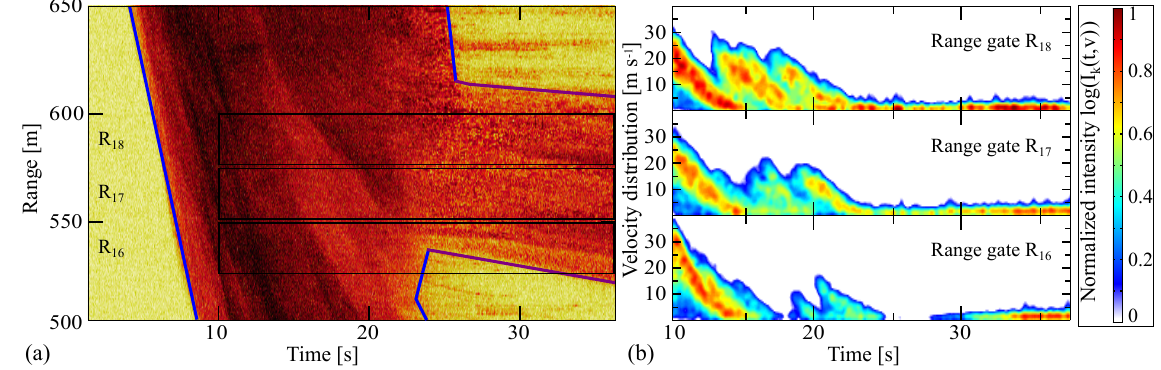
Figure 3. Detail of a partial transition from avalanche no. 17-3030 from the top panels of Fig. 2. (a) Zoomed MTI plot with the location of Doppler range gates. (b) Doppler velocity distribution in the range gates R 16 (525–550m), R 17 (550–575m) and R 18 (575–600m).